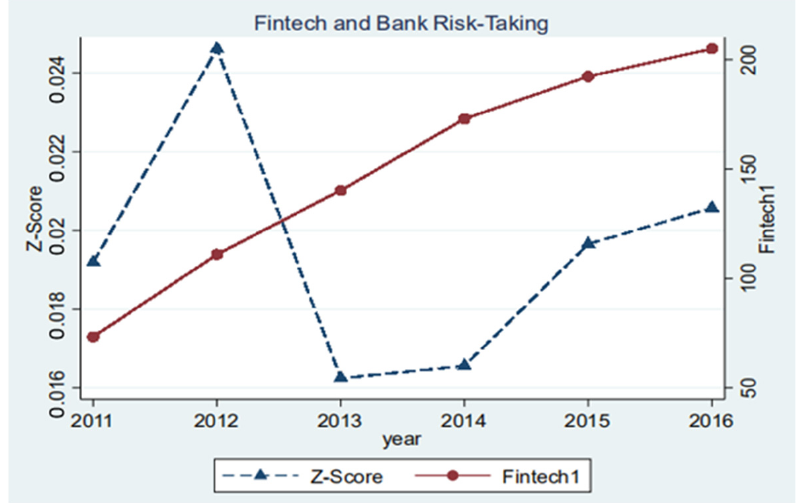
Figure 1. Z-score trend of Fintech and bank risk.